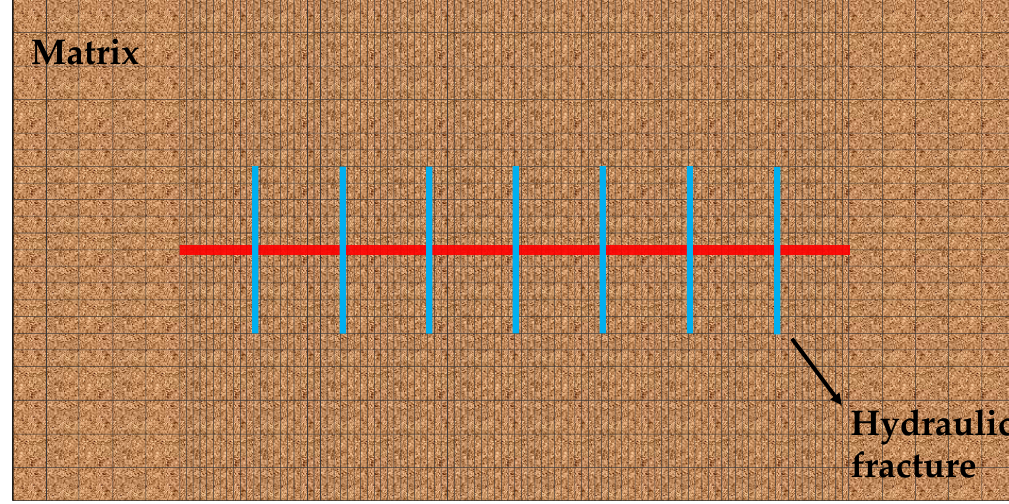
Figure 6. Schematic of fractured horizontal well in shale gas reservoir.